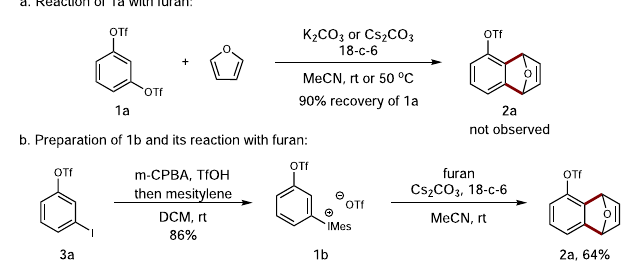
Fig. 2 | Initial studies. a The reaction between 1a and furan in the presence of carbonate salts furnished no desired cycloadduct 2a . b The preparation of